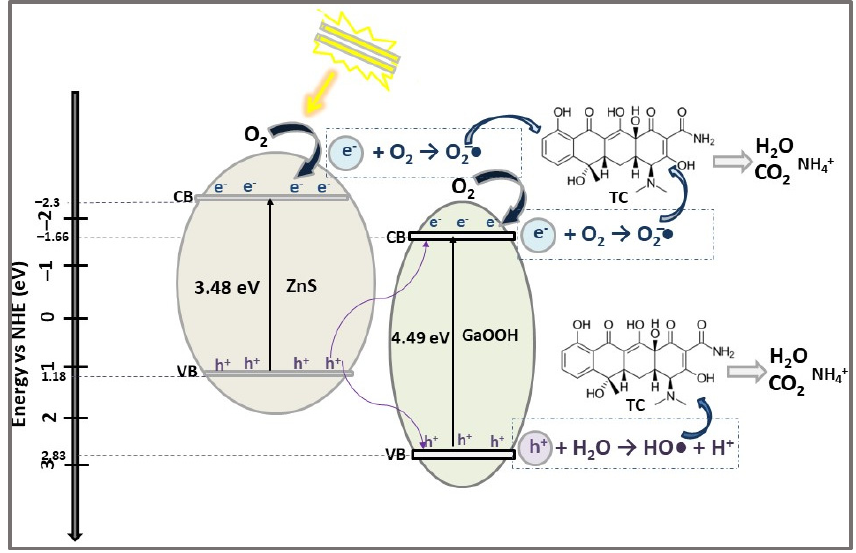
Figure 10. The photocatalytic degradation mechanism of TC antibiotic using ZnS/ GaOOH heterostructure photocatalyst under Vis light irradiation for 150 min.